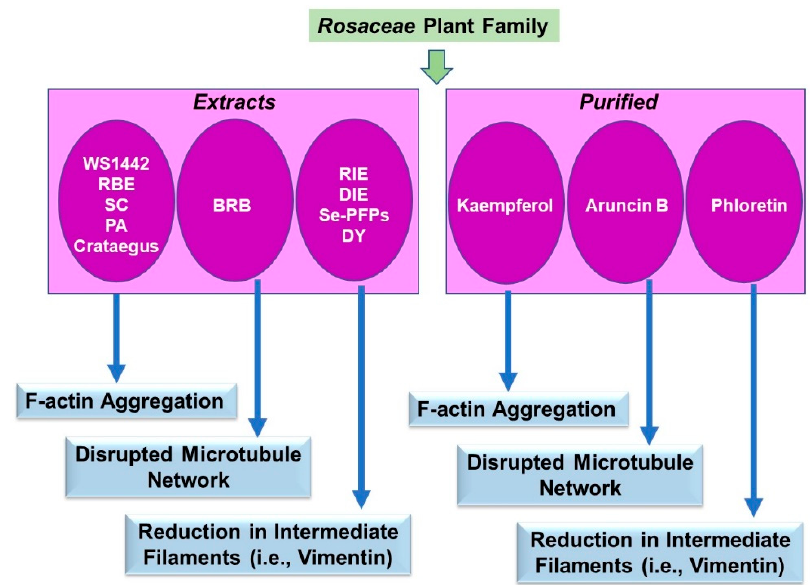
Figure 5. A schematic summary of the effects of metabolites from Rosaceae on cytoskeletal alterations.